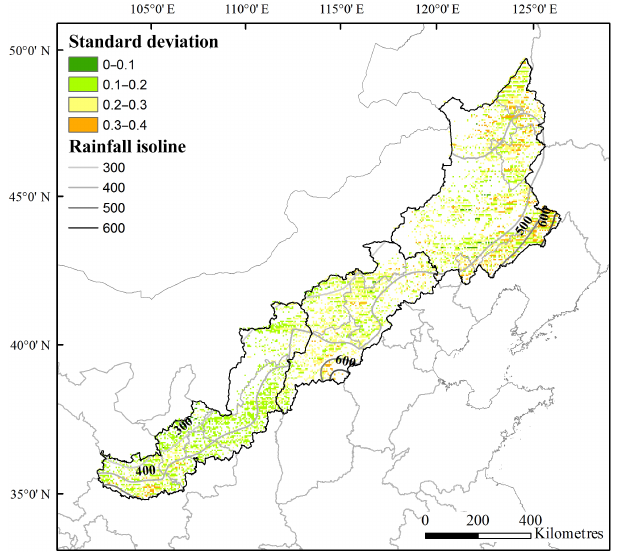
Figure 6. Standard deviation of spring maize drought hazard inten- sity index from 1966 to 2011.